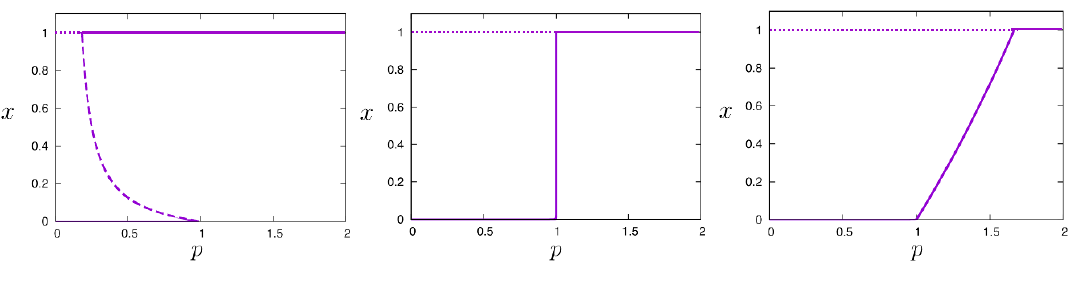
Figure 7 . x (cid:17) N trail versus p in the modi(cid:12)ed ant model (B.9), with (cid:11) = 1, ~ s (cid:17) s N (middle) and 5 : 0 (right), N = 10 5